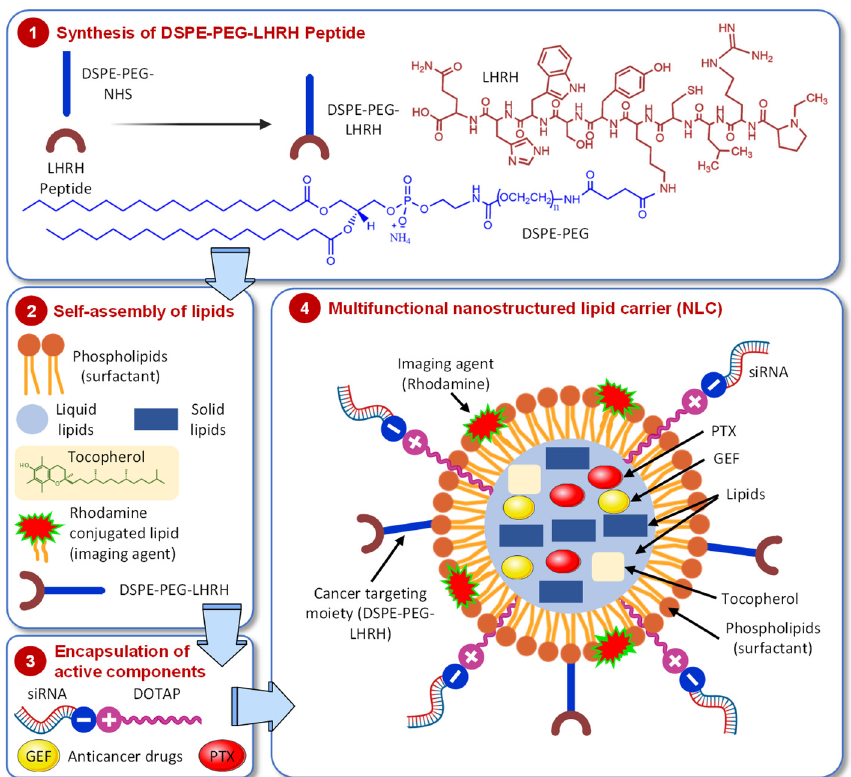
Figure 1. Schematic representation of cancer cell targeted multifunctional and multicomponent nanostructured lipid carrier (NLC). The scheme shows the design and four stages of preparation of the delivery system containing anticancer drugs (gefitinib, GEF, and/or paclitaxel, PTX), imaging agent (rhodamine), targeting moiety (DSPE-PEG-LHRH), and conjugated siRNA targeted to EGF